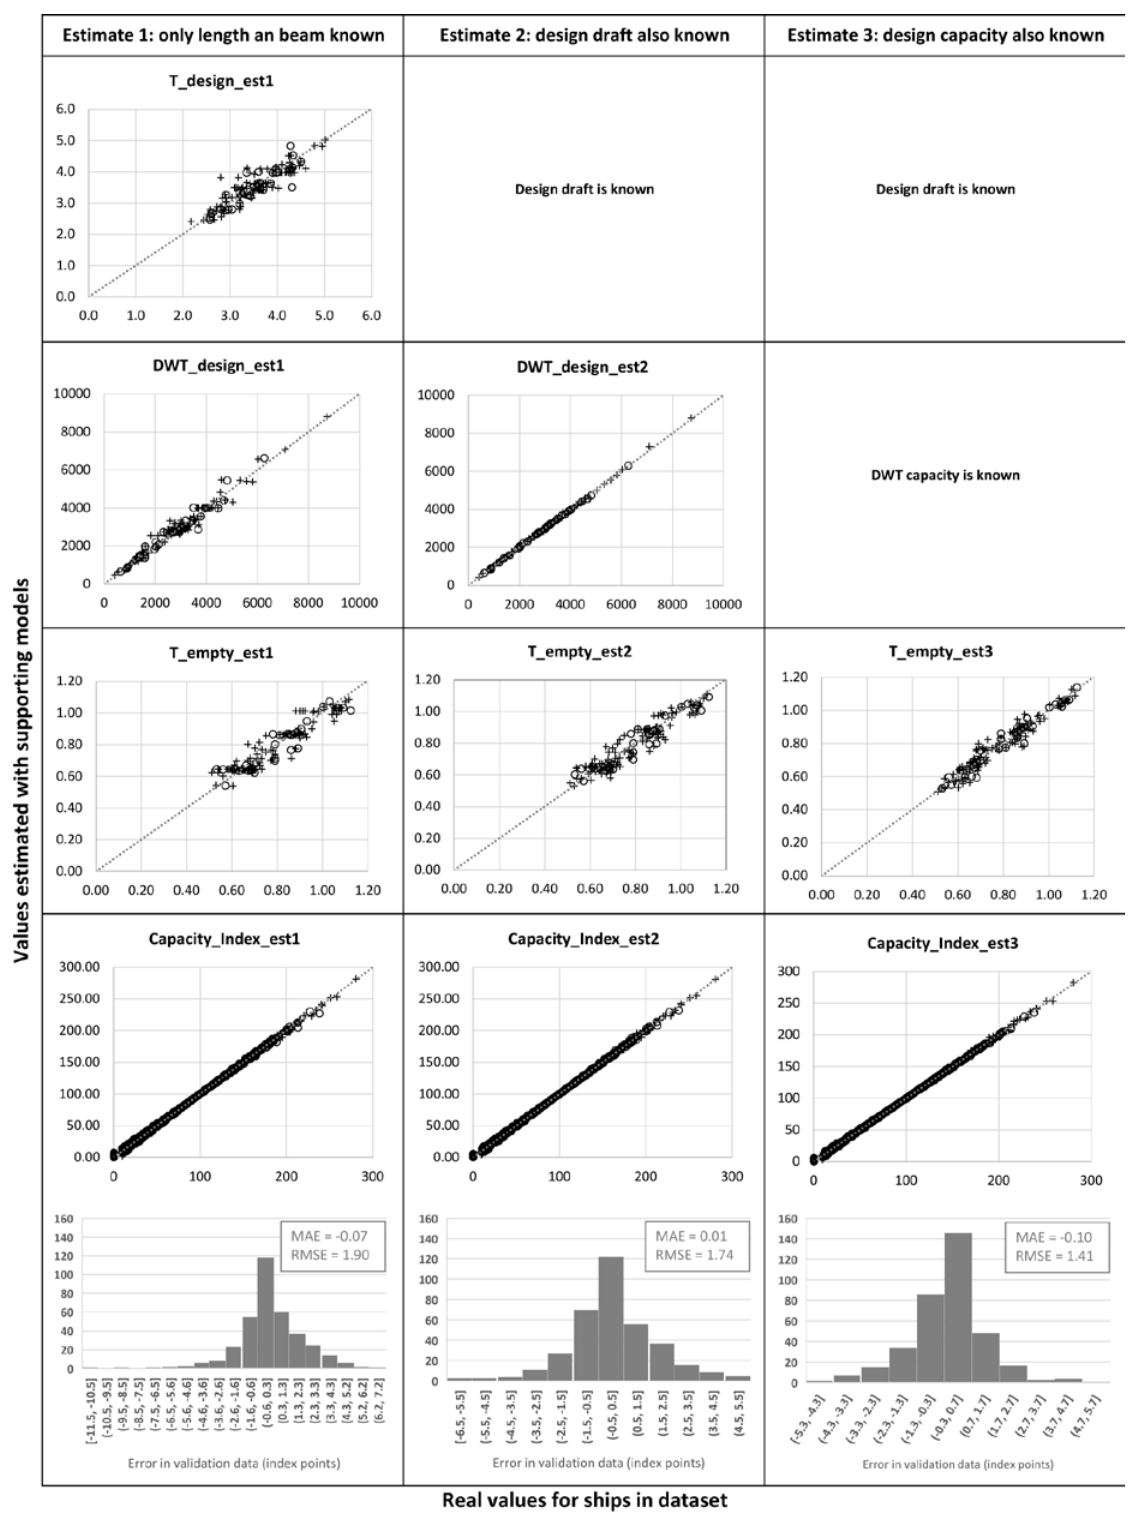
Figure 12. Combined model validation and histogram of error